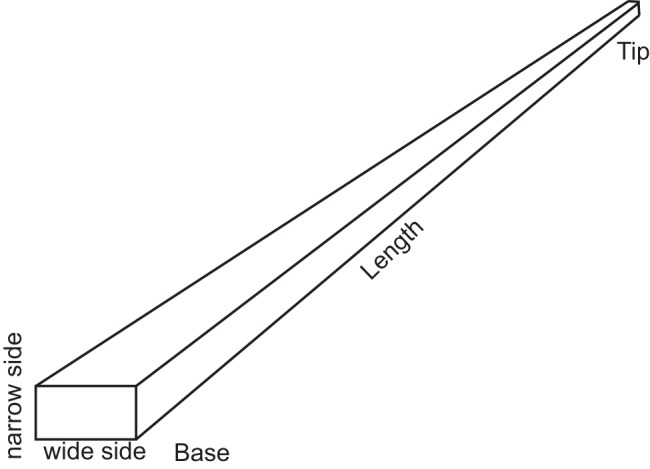
Model of vibrissa.